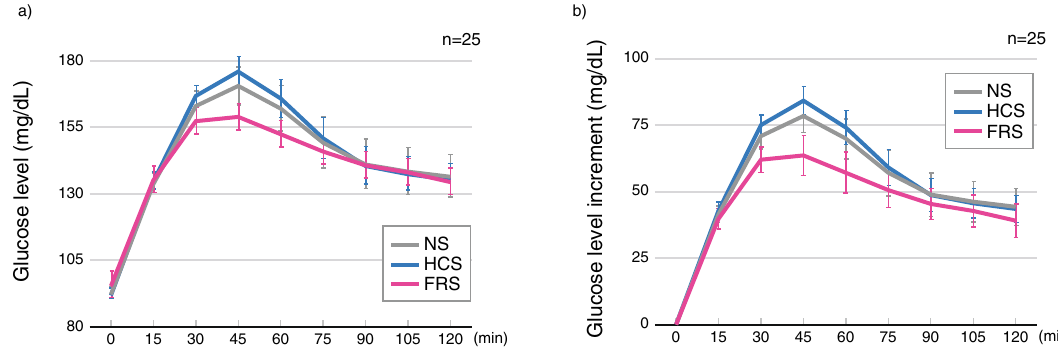
Figure 1. Averaged glucose response curves during the oral glucose tolerance tests under the three experimental conditions. ( a ) mean glucose level across 25 participants ( b ) mean glucose increments from baseline. Error bars indicate standard error of mean. Gray, blue, and pink lines correspond to no sound, high-cut sound, and full-range sound, respectively. A significant main effect of the experimental condition was observed both in the glucose levels and their increments; however no significant interaction was found between time and the experimental condition in either comparison. Between-condition comparisons with Holm’s correction for multiple comparisons showed that the glucose level in the full-range sound condition was significantly lower than that in the high-cut sound condition ( P = 0.025). Moreover, the glucose level increments in the full-range sound condition were significantly smaller than those in the high-cut sound ( P = 0.000012) and no sound conditions ( P =